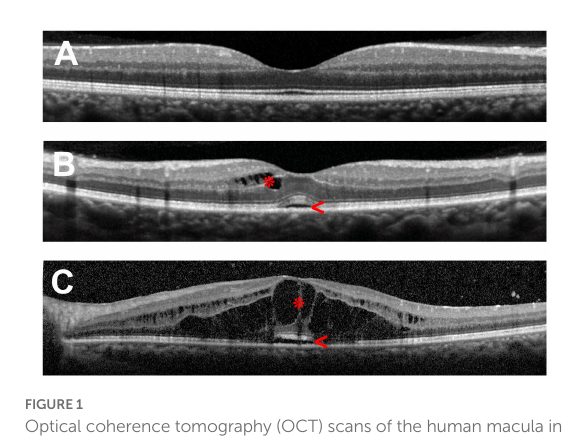
FIGURE 1 Optical coherence tomography (OCT) scans of the human macula in cross-section. (A) Healthy macula. (B) Macula of a patient with mild uveitic macular edema showing small numbers of cystic spaces in the inner retina (asterisk) and limited subretinal fluid (arrowhead). (C) Macula of a patient with severe uveitic macular edema demonstrating extensive retinal cystic changes (asterisk) and subretinal fluid